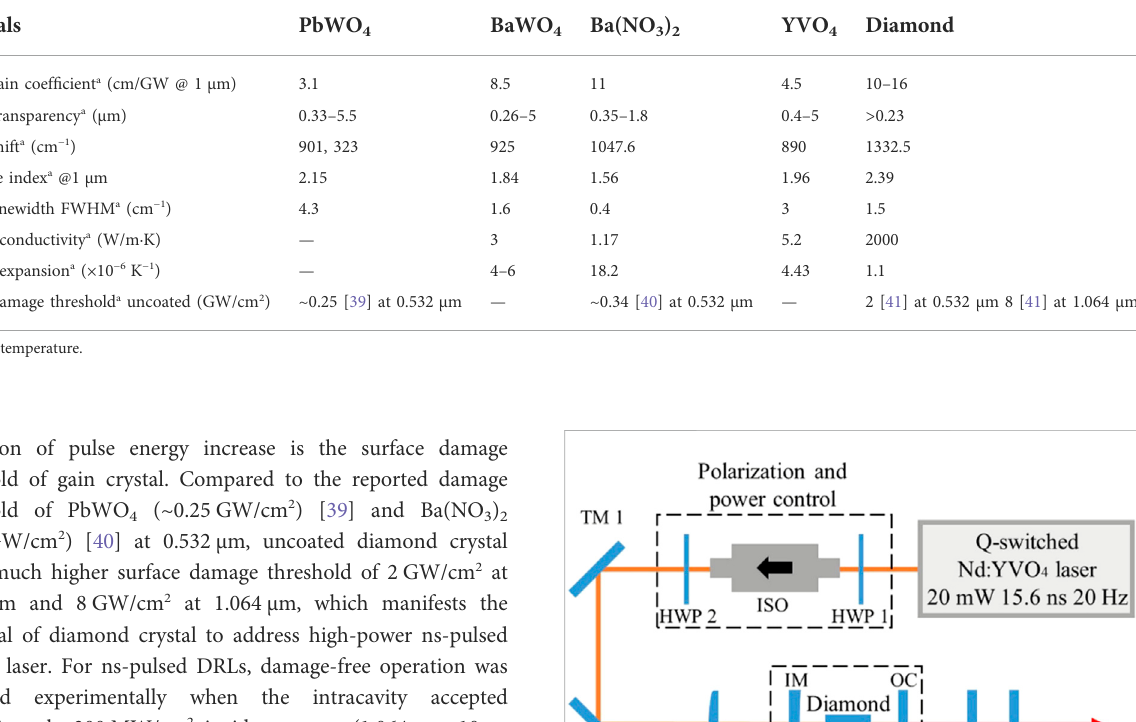
TABLE 1 Optical and physical properties of some of common Raman crystals [16].